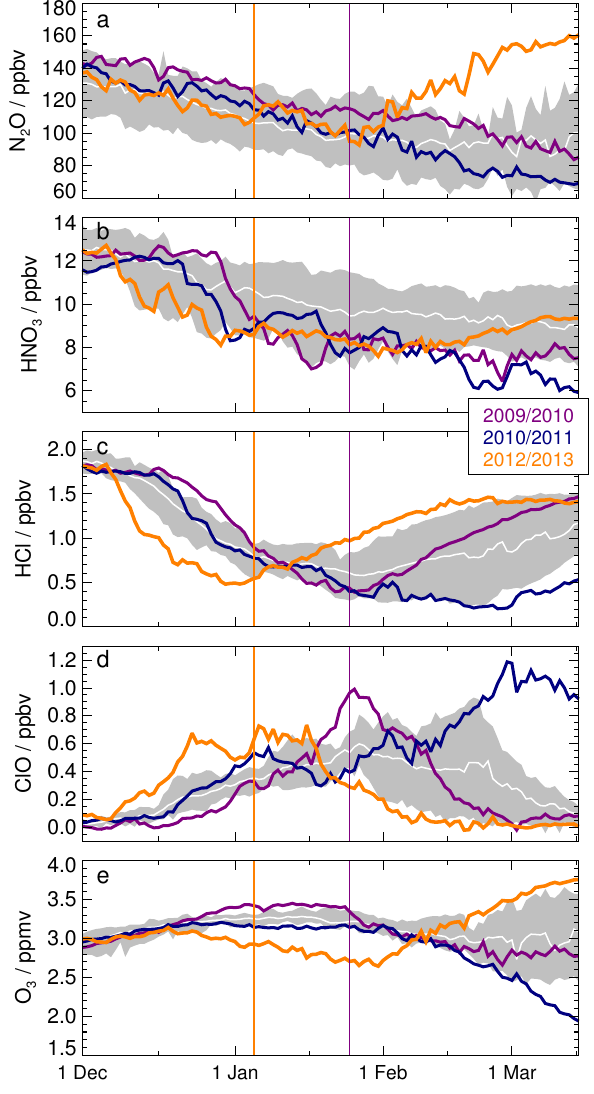
Figure 12. Vortex-averaged MLS trace gases at 490K, in 2012/13 (orange), 2010/11 (blue), and 2009/10 (purple) compared with the range (grey shading) and average (white line) for the other Arctic winters in 2004/05 through 2013/14. (a) N 2 O, (b) HNO 3 , (c) HCl, (d) ClO, and (e) O 3 . Vertical purple and orange lines show the onset dates of the SSWs in 2010 and 2013,